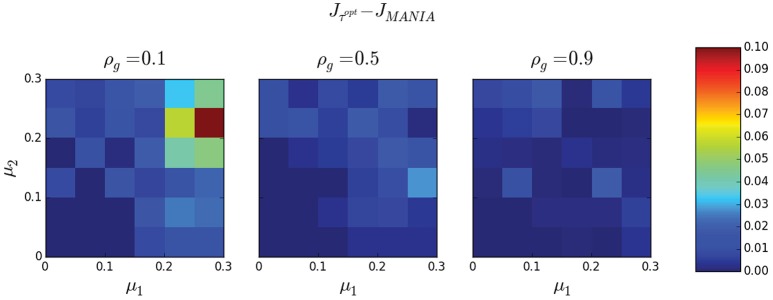
The Jaccard similarity difference (ΔJ=Jτopt-JMANIA) between MANIA and the optimal threshold-based scheme as a function of μ1 and μ2 for sparse networks (ρG = 0.1), medium density networks (ρG = 0.5) and dense networks (ρG = 0.9). Each square is the average of 1000 independent simulations.